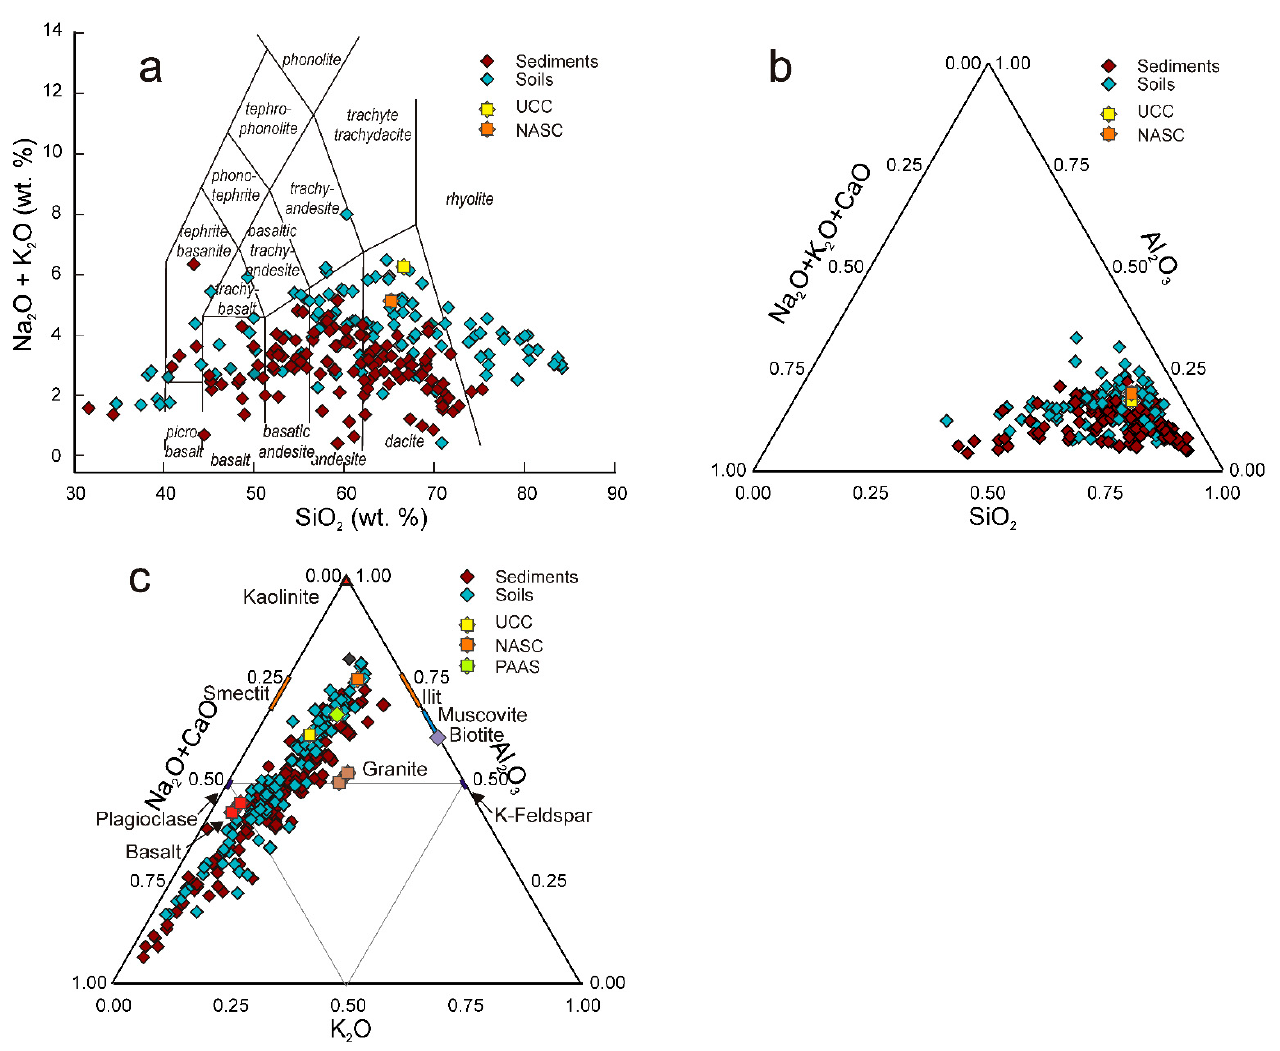
Figure 4. Discriminating total alkali metal oxides vs. SiO 2 biplot ( a ); ternary SiO 2 -Al 2 O 3 -Na 2 O + K 2 O + CaO ( b ); and K-A-CN ( c ) diagrams illustrating the preponderance of felsic material in Zarafshon sediments and soils as well as a small fraction of weathered material.